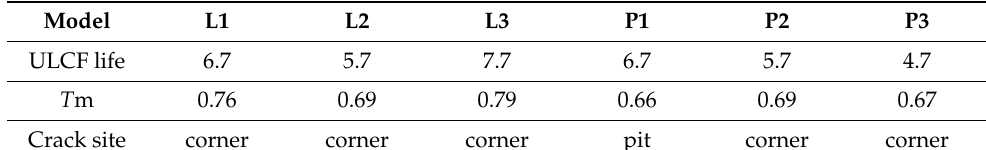
Table 7. Results of simulation of ULCF crack-initiation life for steel piers with corrosion pits in different positions and with different depth-to-diameter ratios.